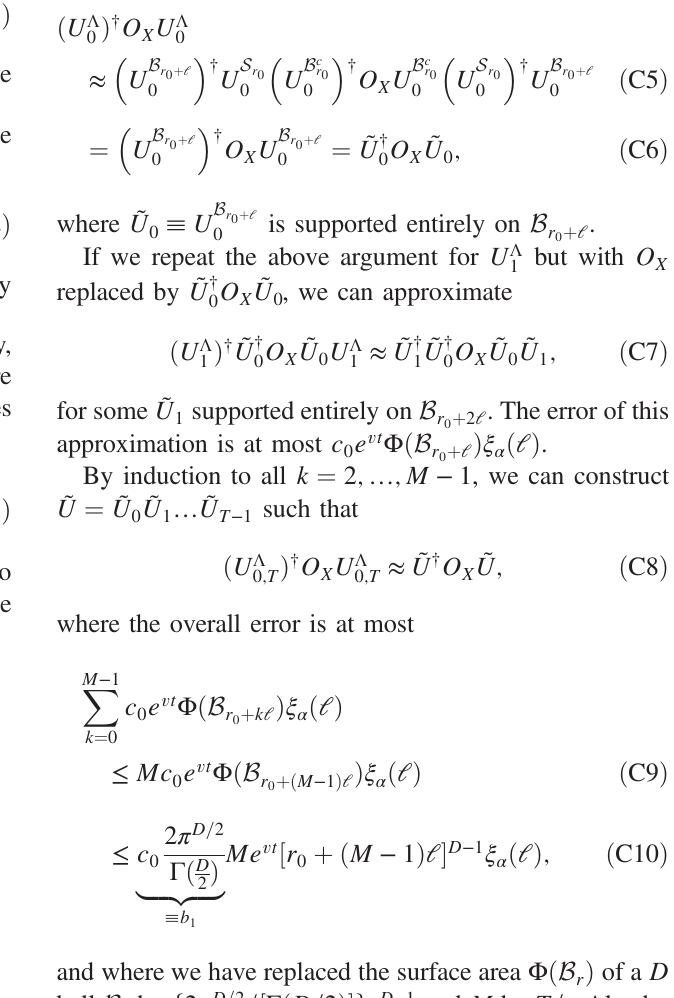
FIG. 7. An example of the subset X ¼ B r ¼ r 0 ; r 0 þ l ; … ; r 0 þ 4 l . The operator O which lies on B c